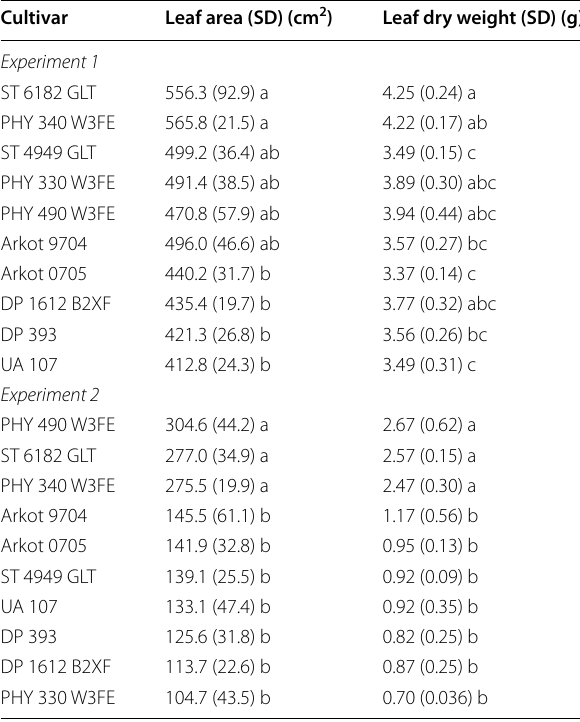
Cultivars followed by the same letter within each measurement are not significantly different based on the 95% confidence interval